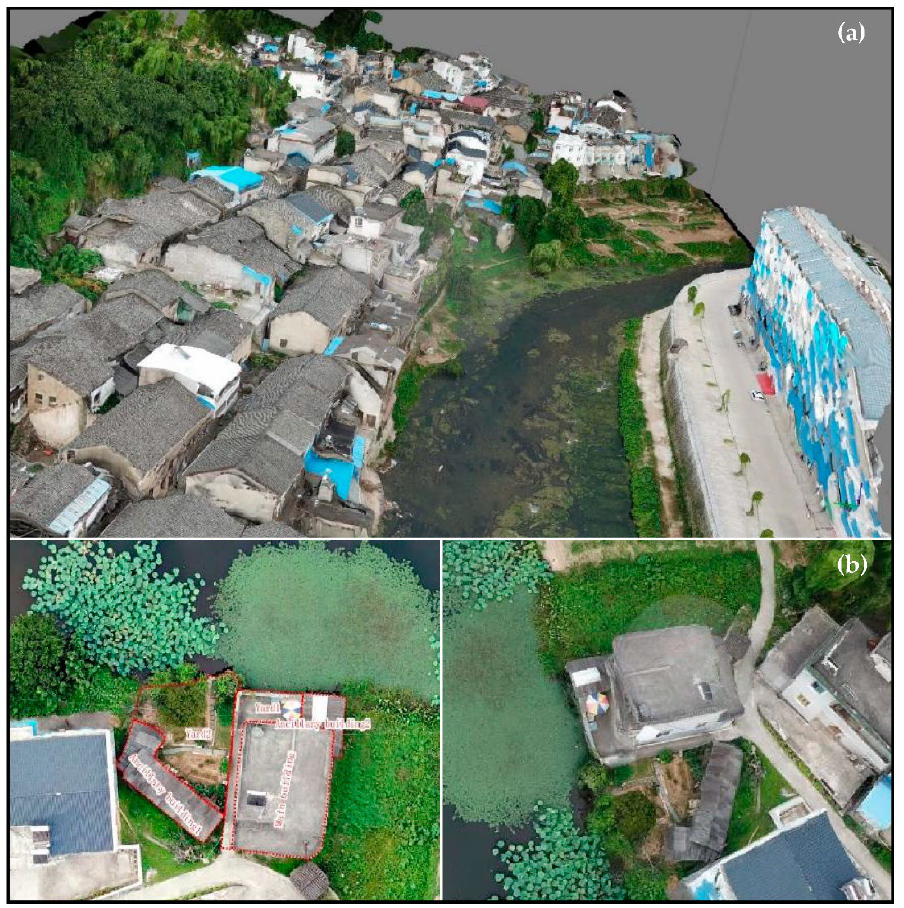
Figure 2. Three-dimensional model to enhance visual interpretation: ( a ) three-dimensional tiled model of Zone B and ( b ) 3D model helps to identify different functional areas of rural homestead from orthographic and different perspectives.